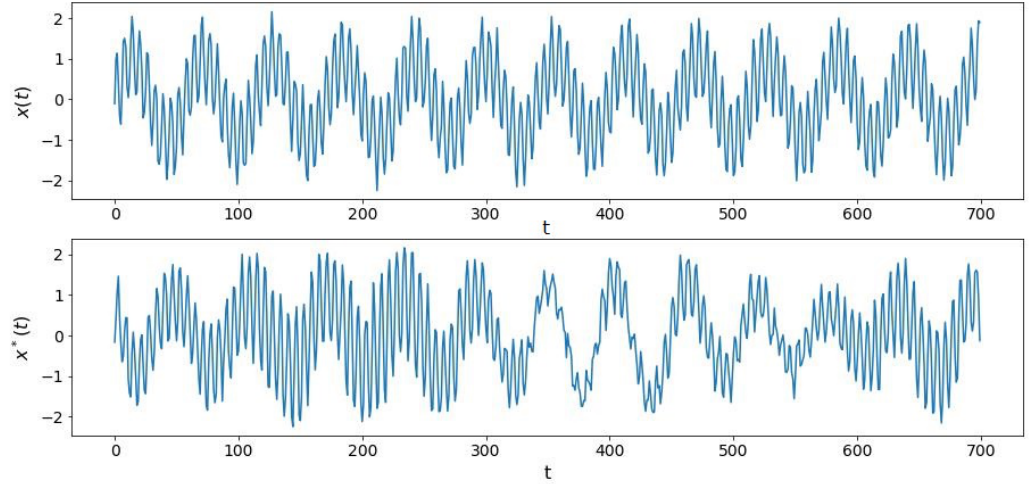
Figure 12. Simulated data ( top ) and IAAFT surrogate of the simulated data ( bottom ).